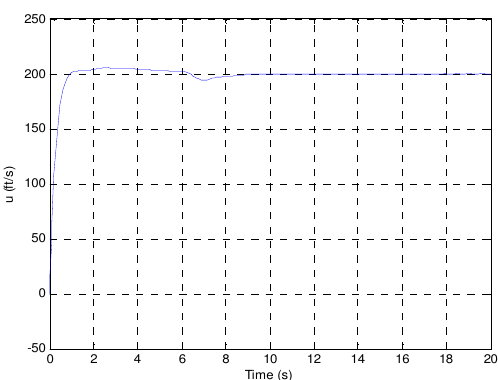
Fig . 11. Airspeed fixed with elevator